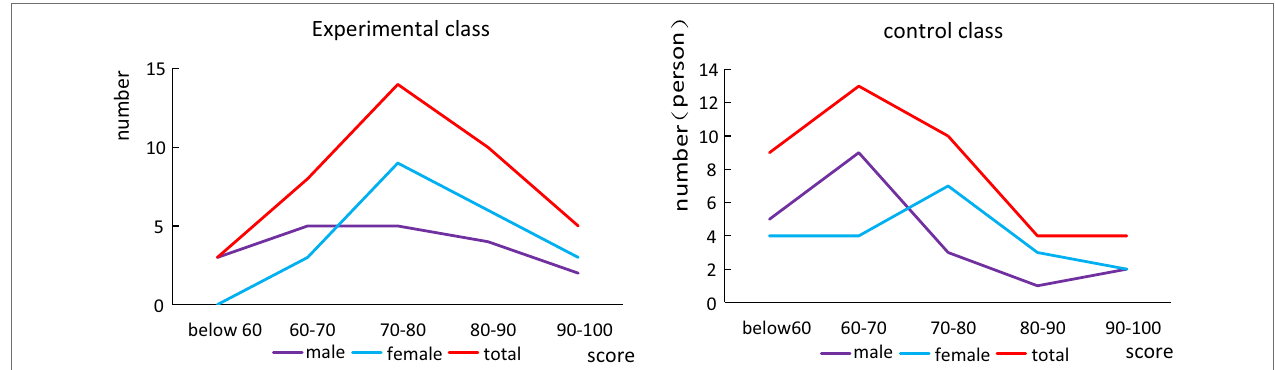
FIGURE 8 | Comparison of the scores of the experimental class and the control class after the experiment.